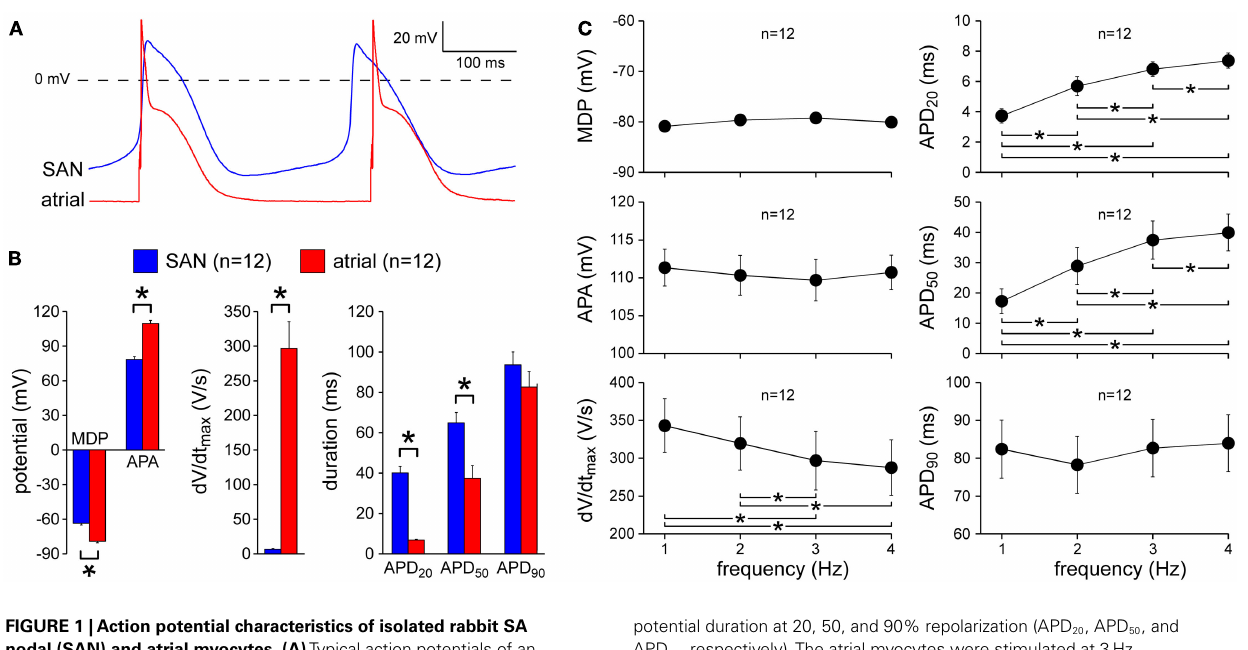
potential duration at 20, 50, and 90% repolarization (APD 20 , APD 50 , and APD 90 , respectively).The atrial myocytes were stimulated at 3Hz. Asterisks indicate significant differences between both cell types. (C) Frequency dependence of the action potential parameters of the atrial myocytes. Asterisks indicate significant differences between stimulus